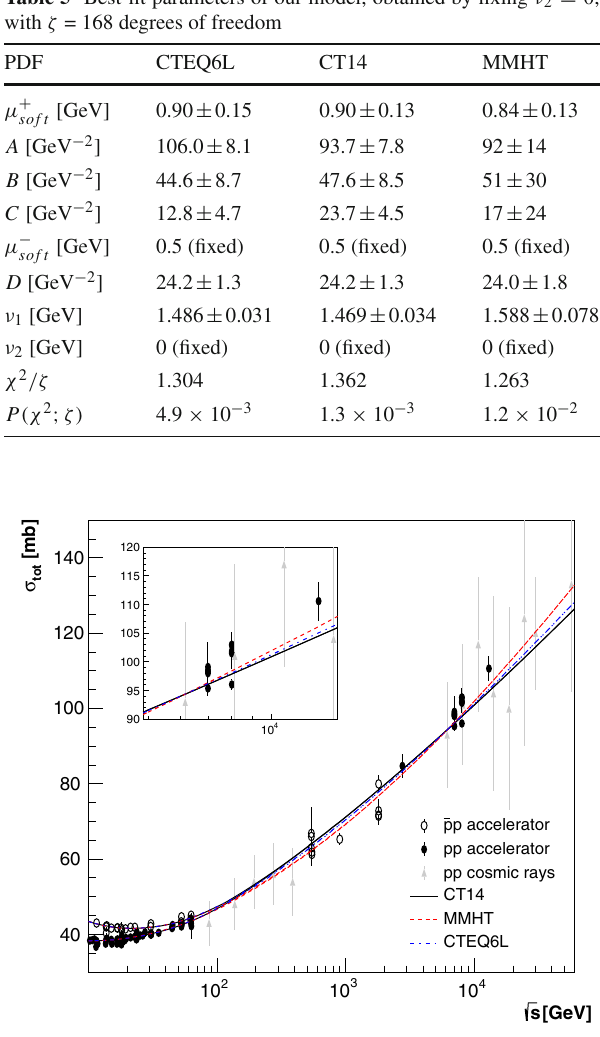
/ ¯ pp ρ pp / ¯ pp data without rising soft Fig. 4 Global 1 σ -fit to σ pp tot and ( s , b ) . Statistical information is provided in Table 4 terms in χ + soft